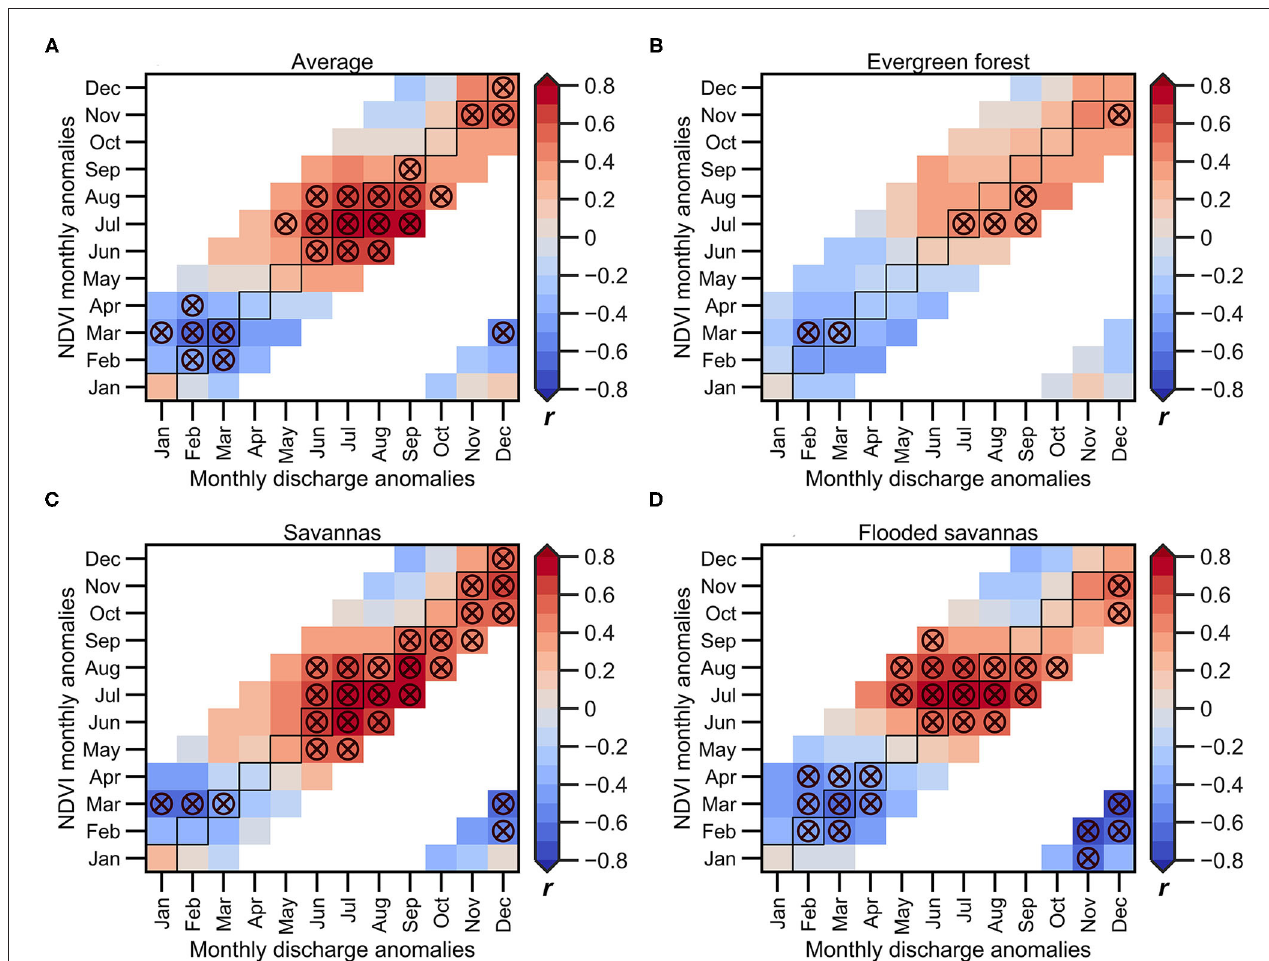
FIGURE 8 | 2000–2018 monthly lagged correlations between river discharge measured at the Porto Velho hydrological station, and NDVI anomalies averaged over the upper Madeira Basin for each predominant land cover types: (A) entire basin, (B) evergreen forests, (C) savannas, and (D) flooded savannas. The NDVI anomalies of the predominant land cover types are calculated below the 1,000m.a.s.l. The horizontal axis indicates the month corresponding to the river discharge anomaly, while the vertical axis indicates the lag of response of the NDVI. Circles marked with the X symbol indicate significant correlations ( p < 0.05). Not computed correlation coefficients are shown in white